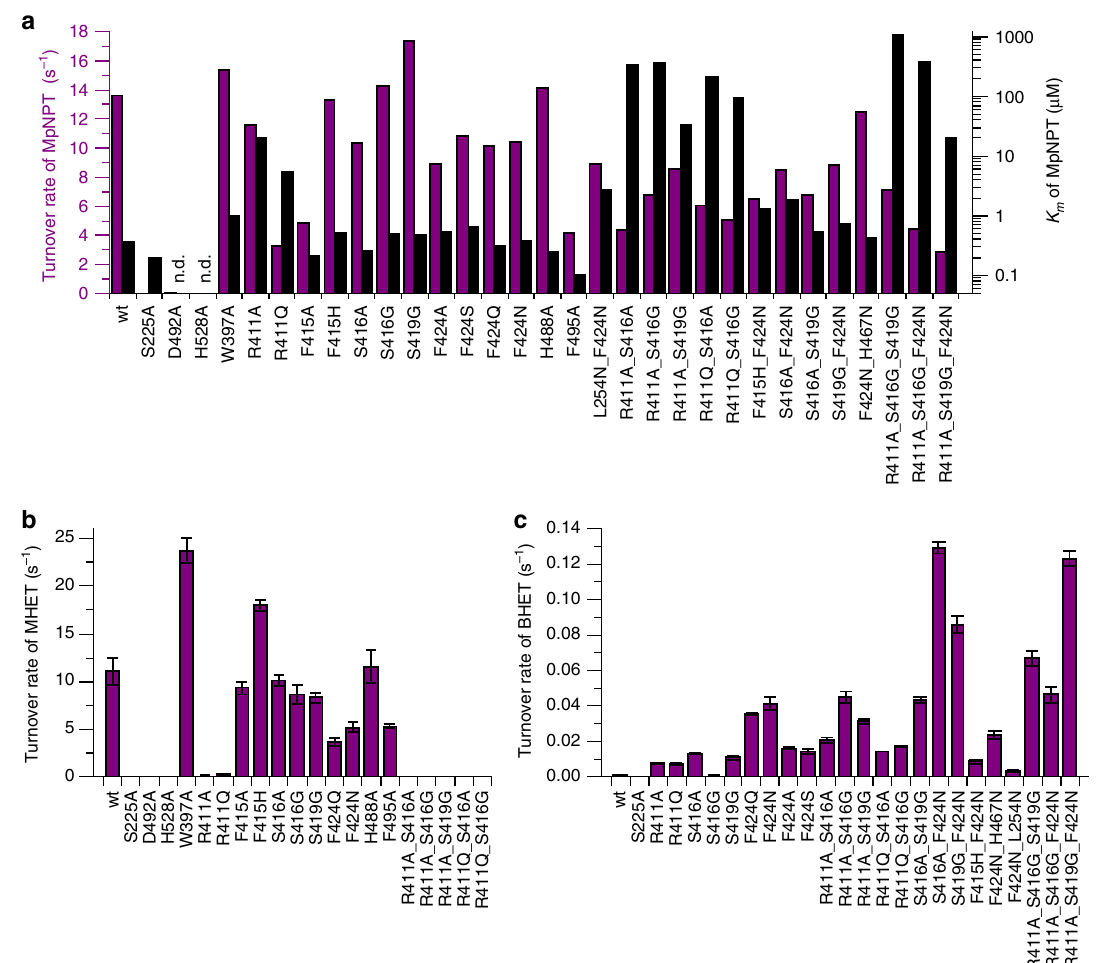
Fig. 4 Catalytic properties of MHETase active-site mutants. a Kinetics of the conversion of MpNPT. The turnover rate (purple y- axis and bars) and K m (black y- axis and bars) were determined by activity measurements at varying substrate concentrations at 25 °C with the different active-site mutants ( x -axis). See methods for the fi tting procedure. b Turnover of MHET. c Turnover of BHET with selected mutants. The turnover rates in b and c were determined by quanti fi cation of hydrolysis products via HPLC analysis and represents the mean value. Error bars indicate the standard deviation of triplicates in these measurements. n.d.: K m for these active-site mutants could not be